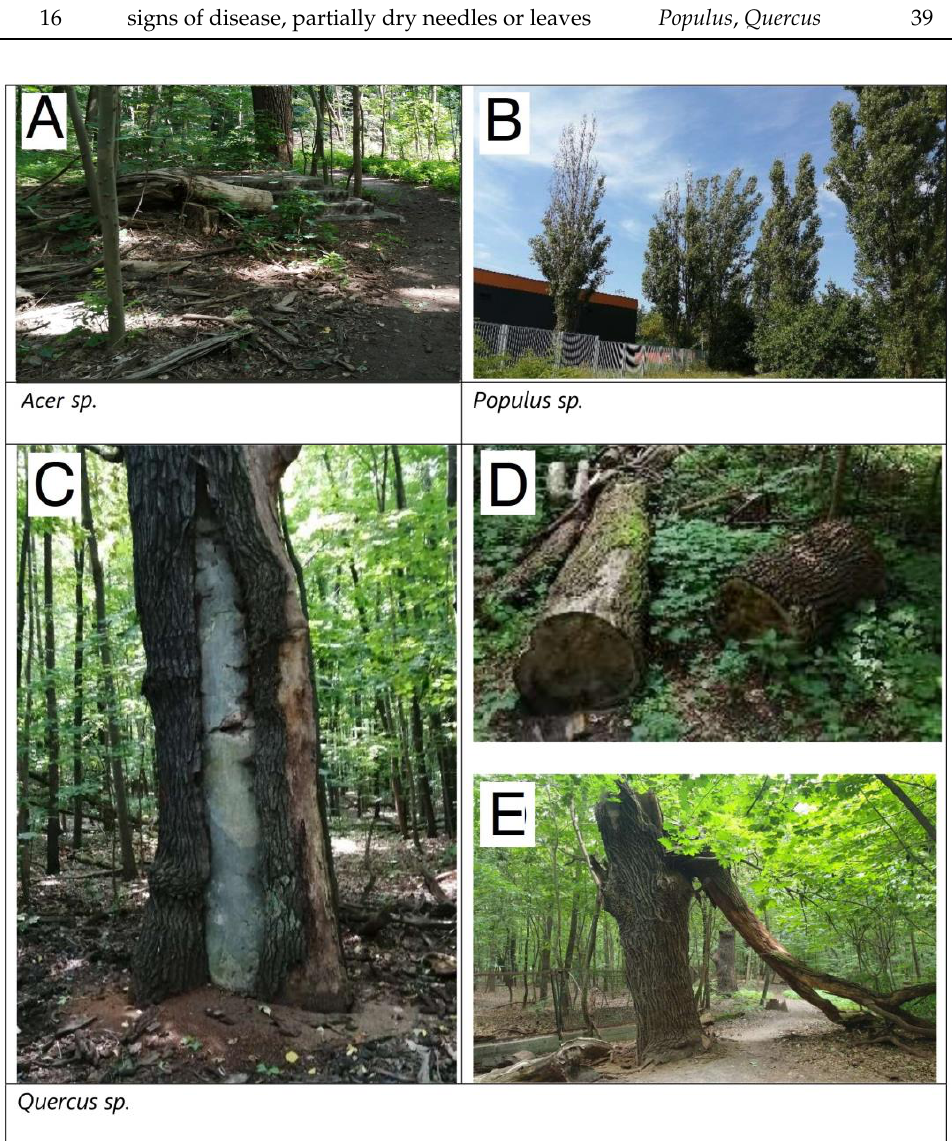
Figure 4. Defoliated trees with damages in the Bielański Forest in Warsaw, Poland: ( A ) fallen branches, ( B ) dried branches, ( C ) tree surgery (concrete guide), ( D ) old fallen branches are not removed from the reserve and are left to nature, ( E ) broken branch of old trees makes it difficult to walk the path in the forest (Photographs by A. Długoński 2022).